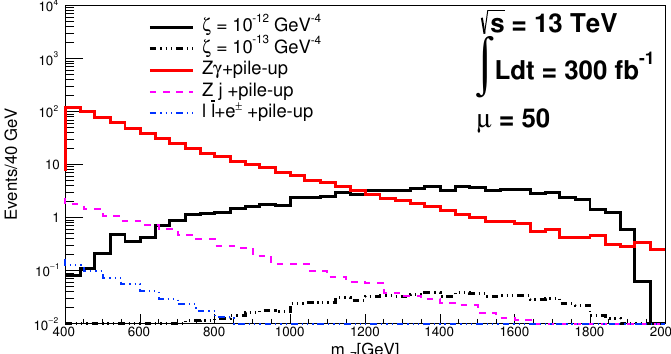
Figure 2 . (cid:13)Z mass distribution for the signal in the ‘ (cid:22) ‘(cid:13) channel for two coupling values ( (cid:16) = 10 (cid:0) 12 ; 10 (cid:0) 13 GeV (cid:0) 4 ) for events within the 0 : 015 < (cid:24) < 0 : 15 proton detectors acceptance and the requirement on transverse momenta p T(cid:13) ; p > 100 GeV. The main contribution to the background T‘ (cid:22) ‘ is the SM Z(cid:13) production in association with protons arising from the pile-up. The plot assumes an integrated luminosity of 300 fb (cid:0) 1 and an average pile-up of (cid:22) = 50.